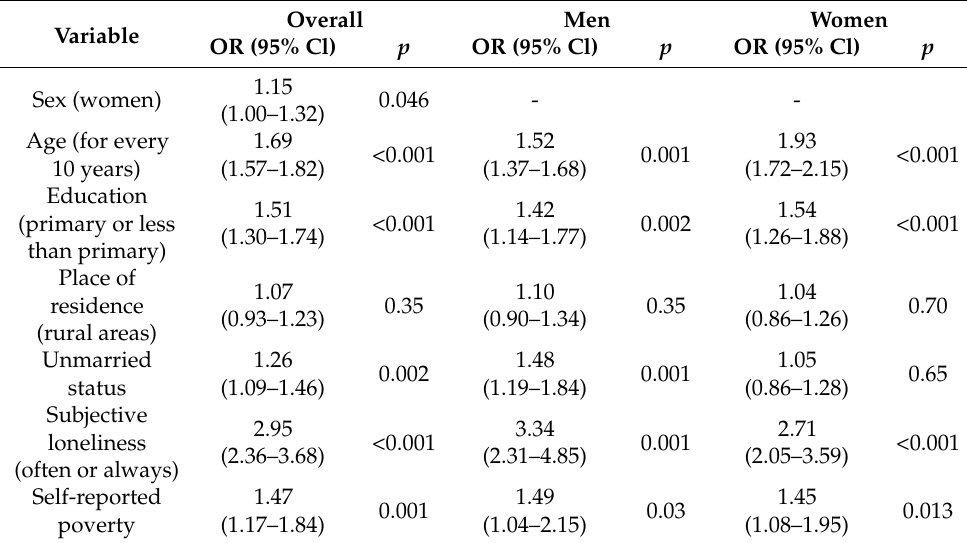
Table 2. Factors associated with poor nutritional status (multiple logistic regression, backward selection